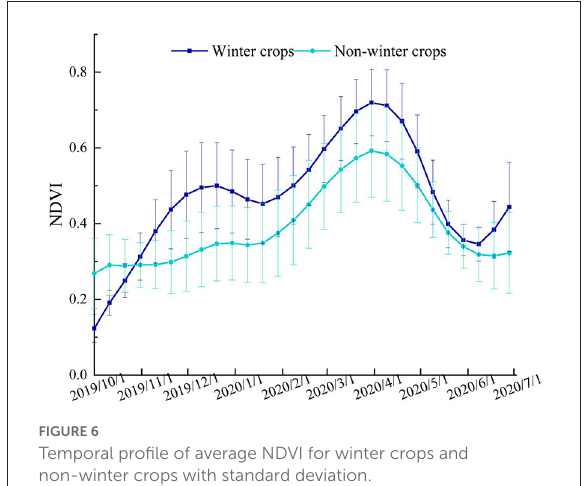
FIGURE6 Temporal profile of average NDVI for winter crops and non-winter crops with standard